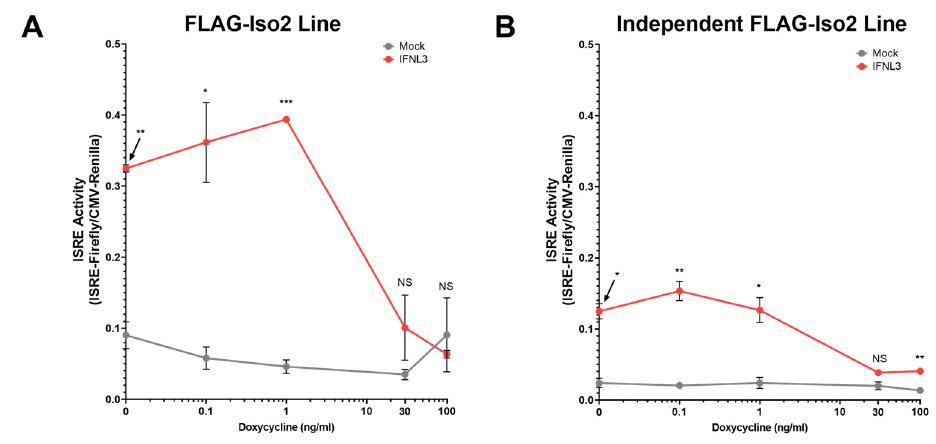
Figure 5. The cellular response to IFNL3 is inversely proportional to FLAG-Iso2 abundance. Two independent FLAG-Iso2 stable lines were transfected with CMV-Renilla and ISRE-Firefly plasmids and dox-treated (dose range between 0–100 ng/mL) for 24 h. Cells were then treated with IFNL3 (100 ng/mL) for 24 h prior to dual luciferase assay. ( A ) FLAG-Iso2 clonal line characterized in Figure 4 and ( B ) an additional independent FLAG-Iso2 clonal line (representative data, two independent experiments). Statistical analysis compares IFNL3 relative to mock-treated cells at a given dox concentration. Error bars represent standard error of the mean. * = p < 0.05, ** = p < 0.01, *** = p < 0.001. NS = not significant.